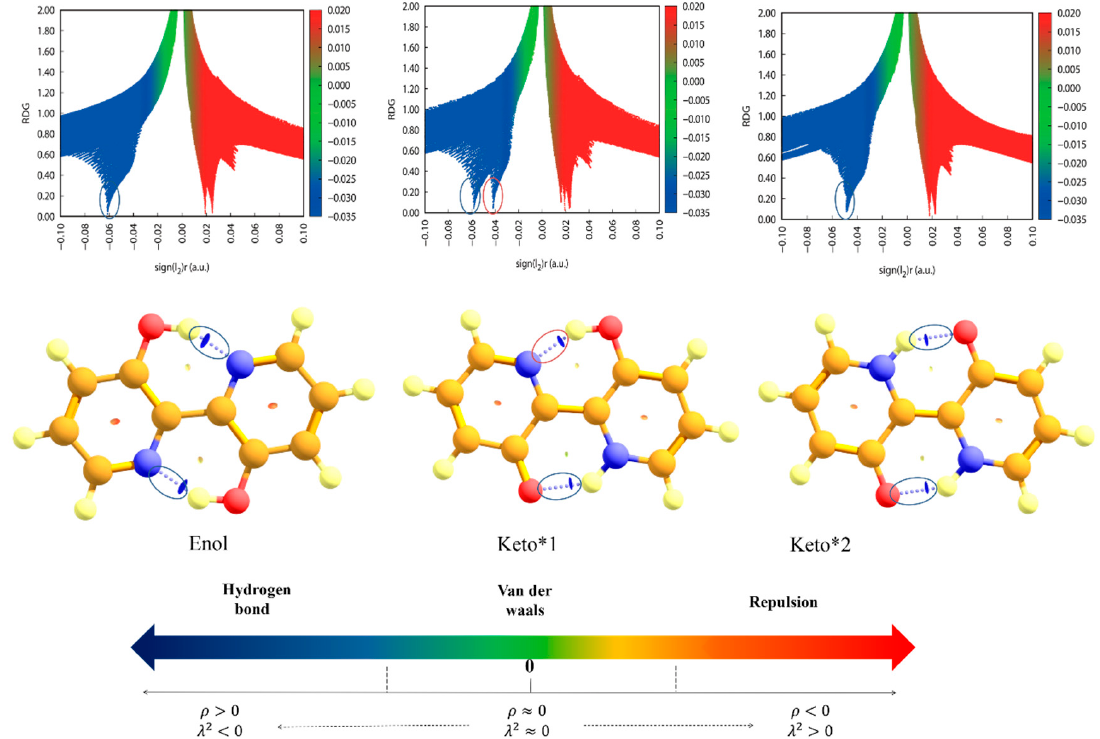
Figure 3. Diagrams of RDG (Function 1) vs. Ω (r) (Function 2) and gradient isosurfaces of BP(OH) 2 at Enol, Keto*1 and Keto*2 states.